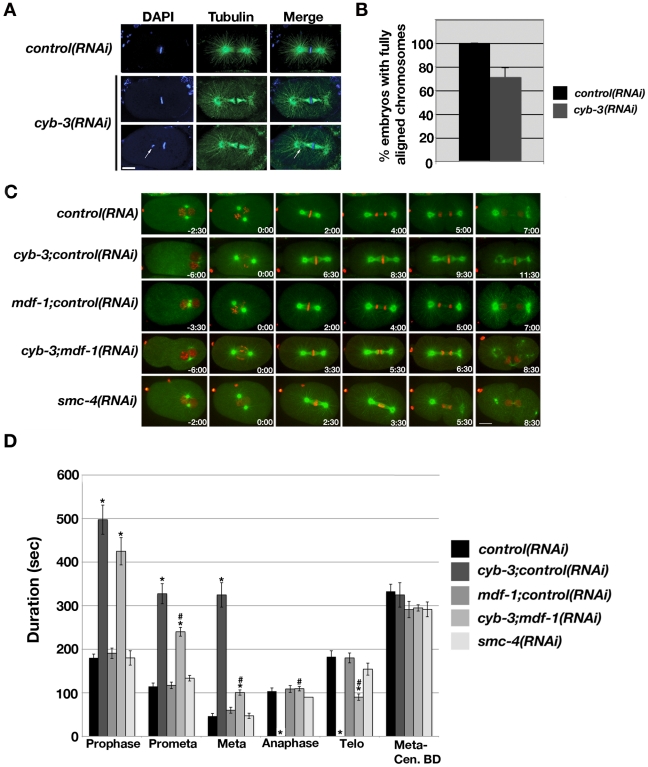

cyb-3(RNAi) results in chromosome congression defects and a prolonged SAC–dependent metaphase delay.A) Control and cyb-3(RNAi) embryos were fixed and stained with DAPI (blue) and an α-tubulin (green) antibody. One-cell embryos at metaphase are shown. Arrow: unaligned chromosome. B) Percentage of fixed control and cyb-3(RNAi) one-cell embryos with complete metaphase chromosome alignment (control(RNAi), n = 25; cyb-3(RNAi), n = 42; Error bars: SEM; p = 0.001). C) Selected live images of OD57 embryos treated with the indicated RNAi combinations. 0:00 =  NEB. Images immediately to the left of 0:00 correspond to PNM. D) Duration of mitotic stages after treatment with various RNAi combinations. *: p<0.05 compared to control(RNAi); #: p<0.05 compared to cyb-3;control(RNAi). n =  embryos; Error bars: SEM; control, n = 7; cyb-3;control(RNAi), n = 8; mdf-1;control(RNAi), n = 10; cyb-3;mdf-1(RNAi), n = 17; smc-4(RNAi), n = 7. Scale bars: 10 µm.